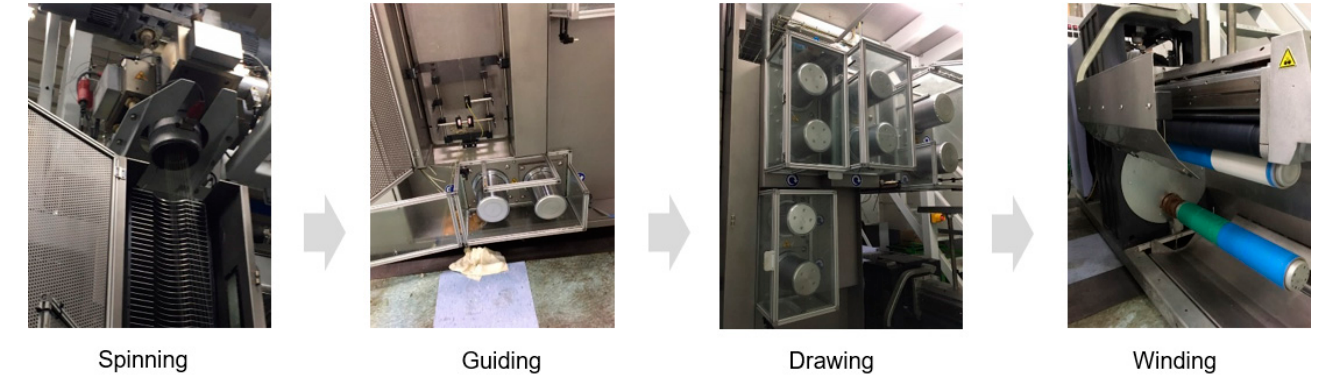
Figure 2. Process for fabrication of yarn for shielding fiber.